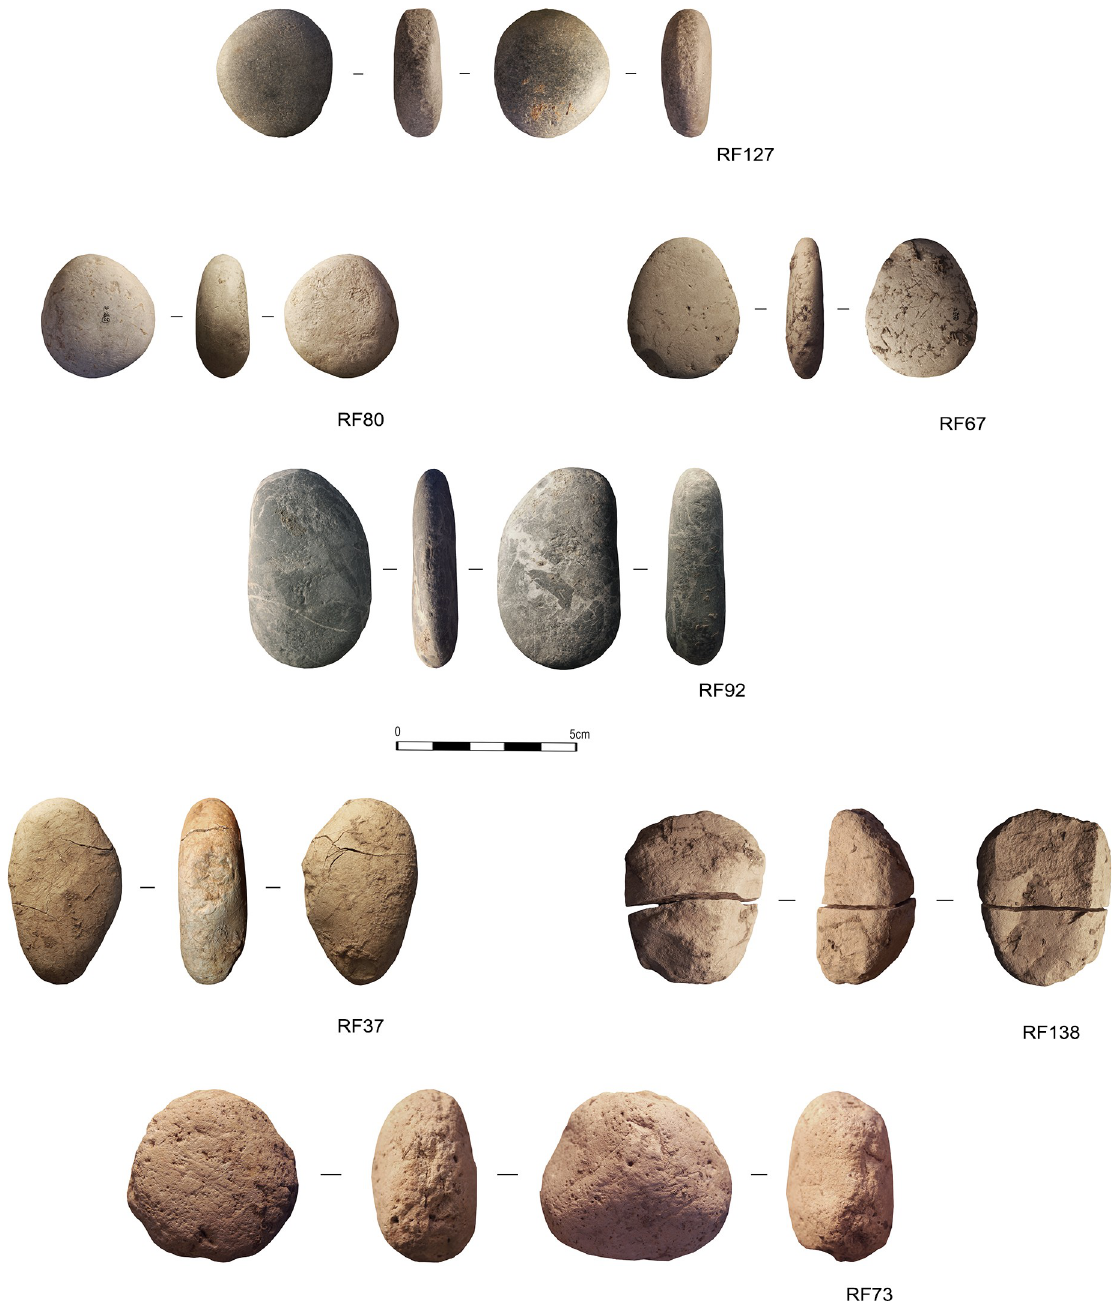
Fig 2. The Protoaurignacian and Aurignacian pebbles discovered in Fumane Cave (Verona, Italy).